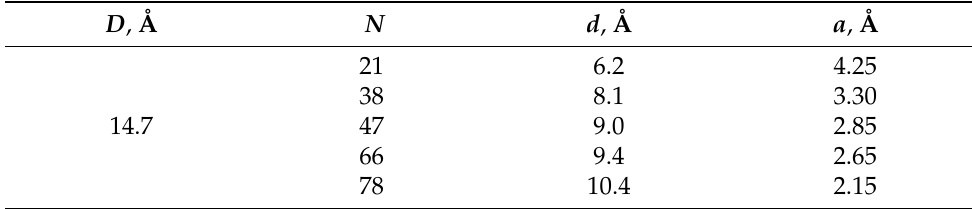
Table 1. The size of the structural